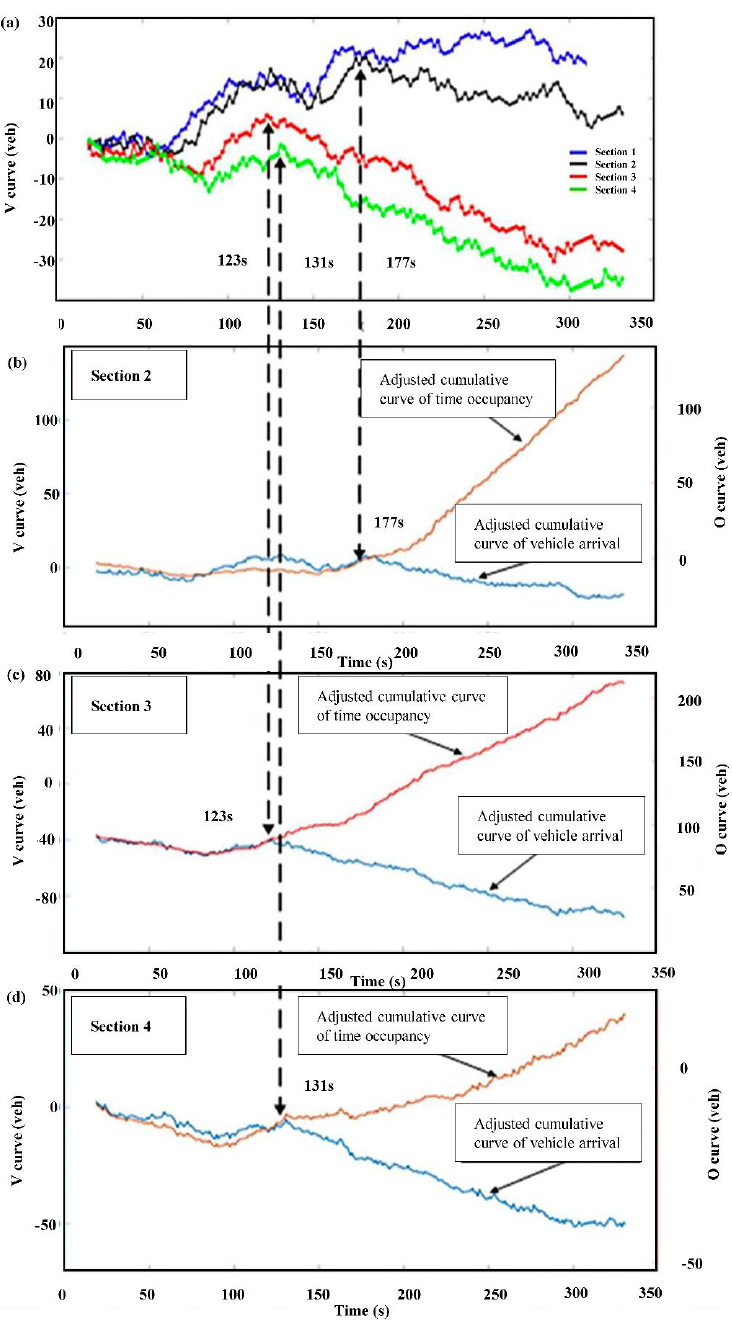
Figure 2. Confirmation of traffic capacity drop time of each tunnel section.